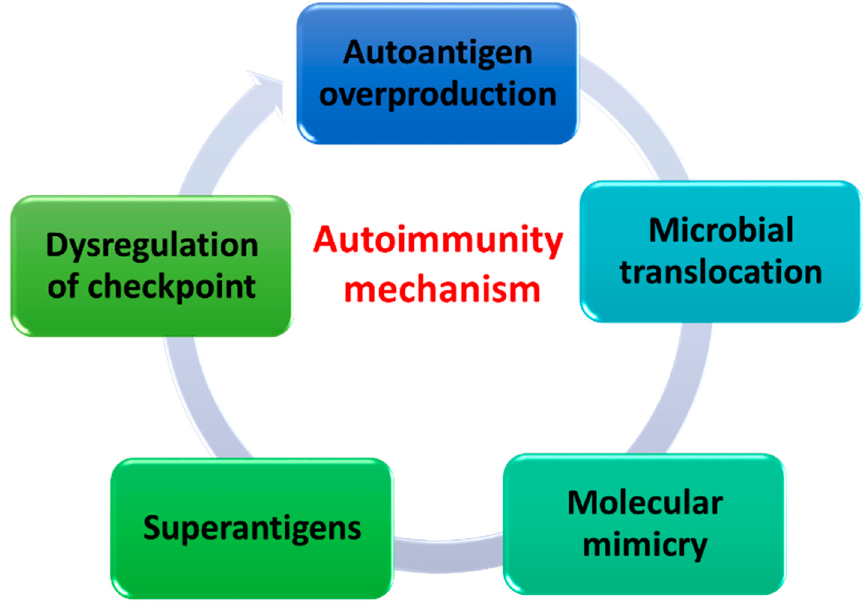
Figure 6. Autoimmune mechanisms caused by changes in oral dysbiosis (based on [101]).